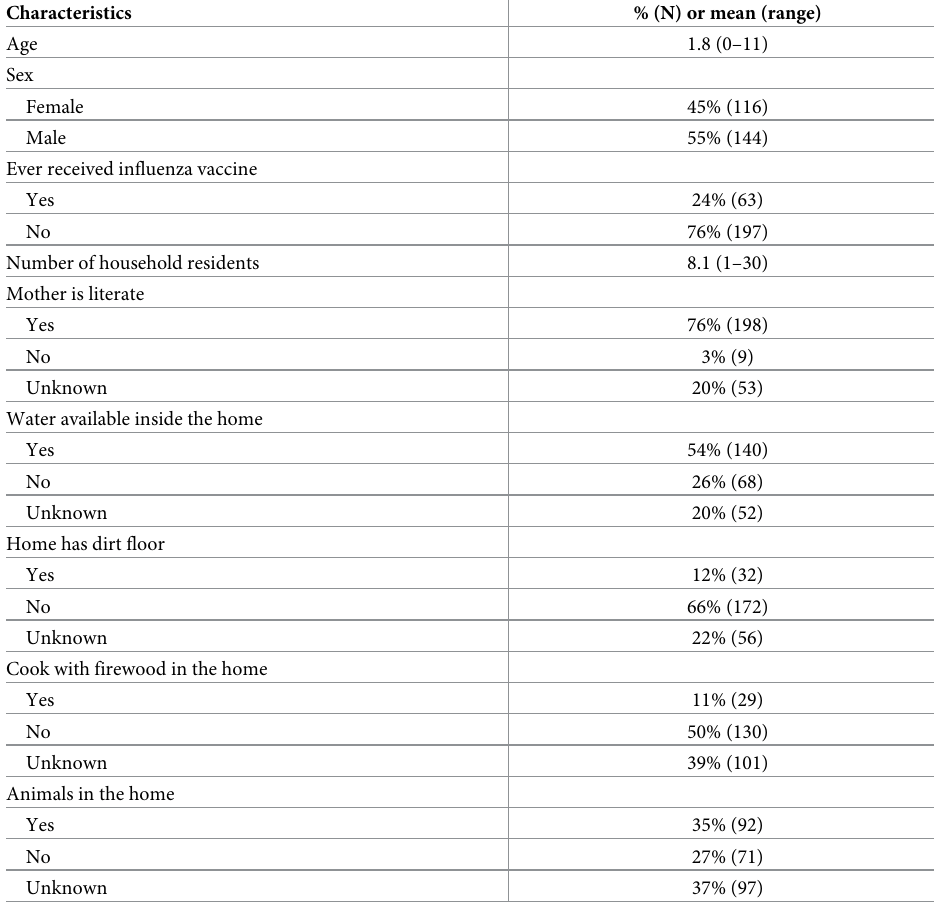
Table 1. Characteristics of the study cohort at time of each participant’s first sera sample.